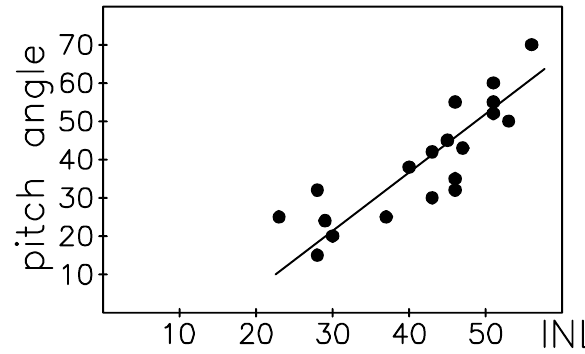
Fig. 3. The latitudinal dependence of the burst pitch